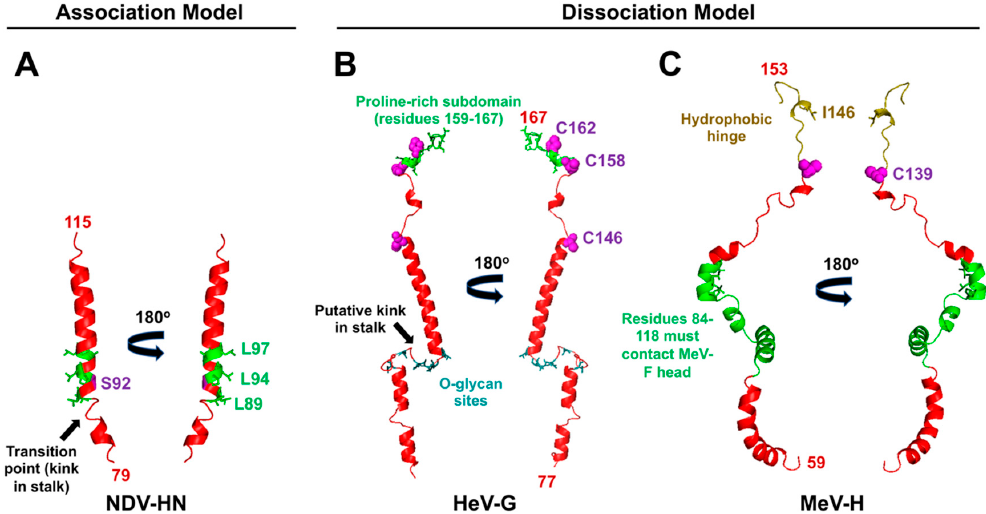
Figure 4. The F activation residues mapped onto the extant NDV-HN and modeled HeV-G and MeV-H stalk domain structures. ( A ) Two orientations of a cartoon representation of residues 79 –115 in the NDV-HN stalk (PDB accession no. 3T1E) are shown in red. The hydrophobic residues shown as green sticks are those implicated in NDV-F activation [55,103,104] . A black arrow points to the transition point from the 7mer heptad repeat, supercoiled region to 11mer heptad repeat, straight region. Residue S92, colored in purple, signifies a position in the stalk where a disulfide linkage is not tolerated [103] . ( B ) Two orientations of a cartoon representation of the modeled HeV-G stalk domain (residues 77-167) are shown in red [105] . The proline-rich subdomain implicated in HNV-F activation is shown in green [106] . Cysteine residues involved in dimer-of-dimers formation are shown as magenta spheres [90] . The black arrow points to the putative helical transition site. O-glycosylated residues are shown as cyan sticks [107] . ( C ) Two orientations of a cartoon representation of the modeled MeV-H stalk region (residues 59-153) are shown in red [105] . Green residues are those implicated in MeV-F triggering [108] . Cysteine residue C139, involved in dimerization, is shown as a magenta sphere [109] . The hydrophobic hinge region that bridges the stalk to the head domain is colored olive, and residue I146, whose presence is essential for fusion, is shown as sticks [109] .